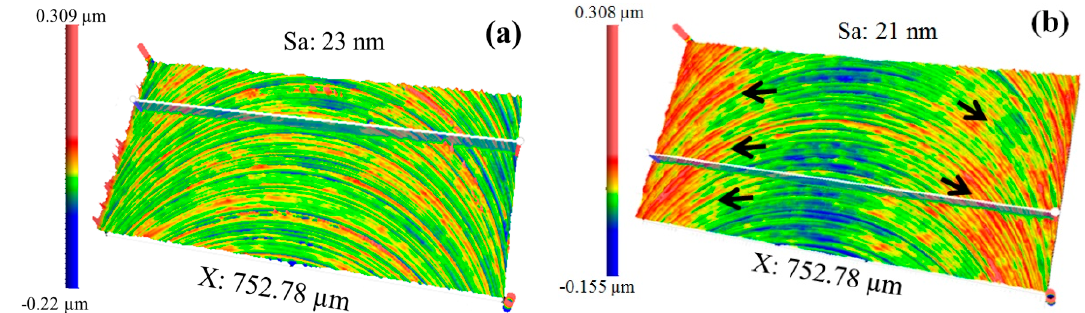
Figure 4. 3D surface topographies for the feed rate at ( a ) 0.4 µm/flute and ( b ) 0.8 µm/flute.